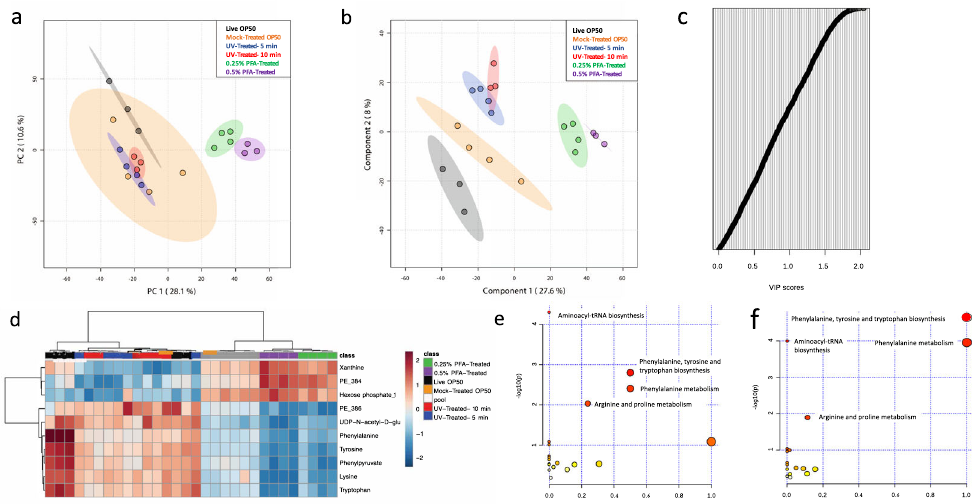
Fig. 3 The metabolome of worms fed PFA-treated OP50 differs from the metabolome of the worms fed live and UV-treated OP50. a Principal component analysis and b PLS-DA analysis of untargeted LC-MS metabolomics data of C. elegans fed with control, UV-treated and PFA-treated OP50. c VIP analysis of component 1 of LC-MS metabolomics data of C. elegans fed with control, UV-treated and PFA-treated OP50. d Heatmap of targeted LC-MS metabolomics data of C. elegans fed with control, UV-treated and PFA-treated OP50. e Pathway analysis of metabolites with signi fi cant abundance change between worms grown on mock-treated and 0.25% PFA-treated OP50 and f between worms grown on mock-treated and 0.5% PFA-treated OP50. PE_384 = Phosphatidylethanolamine (PE) (38:4) and PE_386 = PE (38:6).